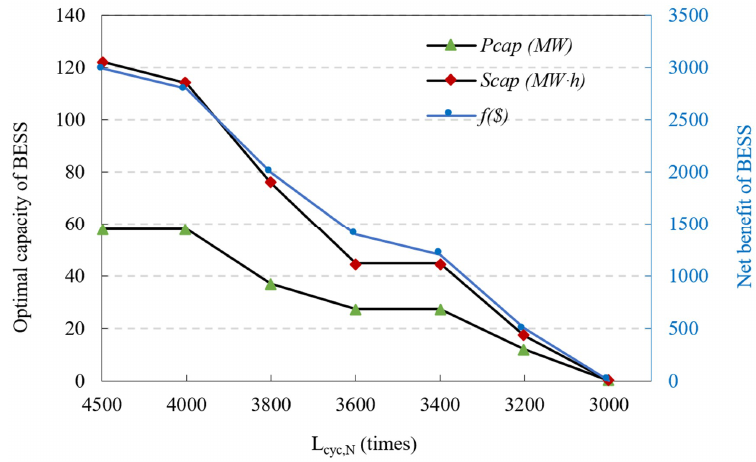
Figure 9. Optimal results under different cycle life of BESS. L cyc,N : cycle life of BESS with fully